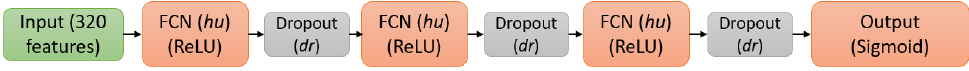
Figure 8. Visual representation of MLPNN classifier. The MLPNN architecture consists of three fully-connected hidden layers with hidden units hu and the ReLU activation, each followed by a dropout layer with a dropout rate dr